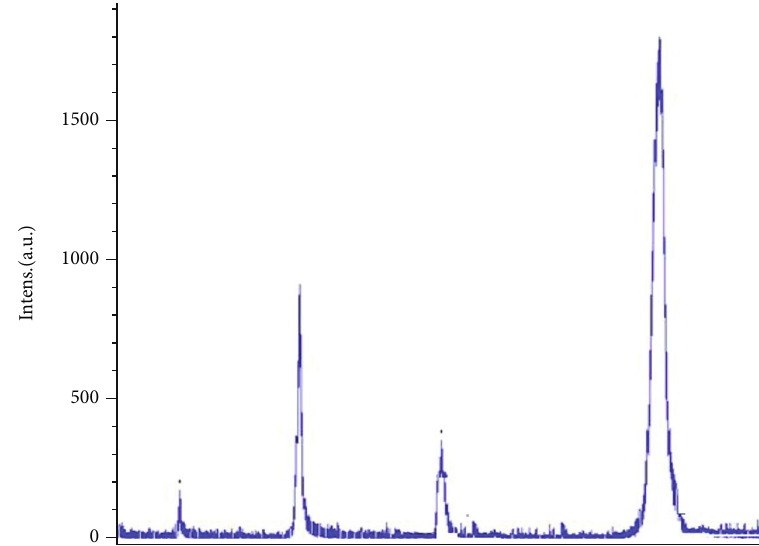
Figure 1: HPLC showing peaks of crude extract. The sample showed four protein peaks in HPLC run and second peak was positive for hemagglutination test.